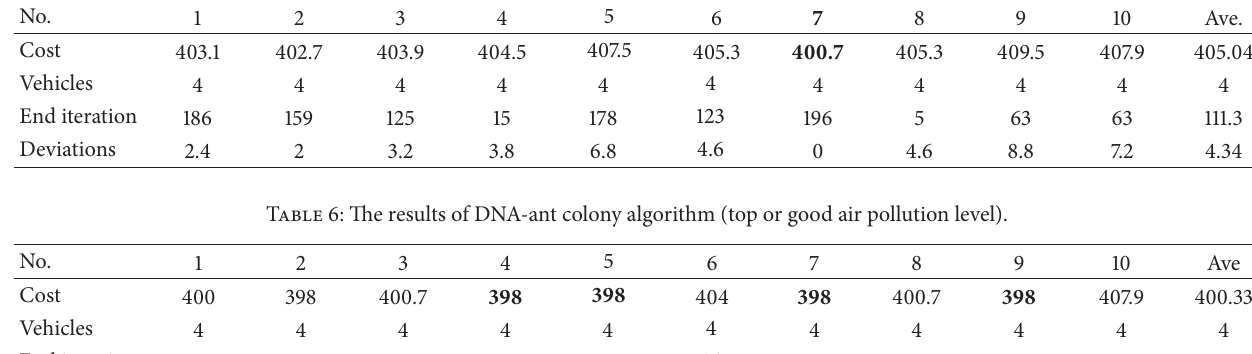
Table 5: The results of basic ant colony algorithm (top or good air pollution level).